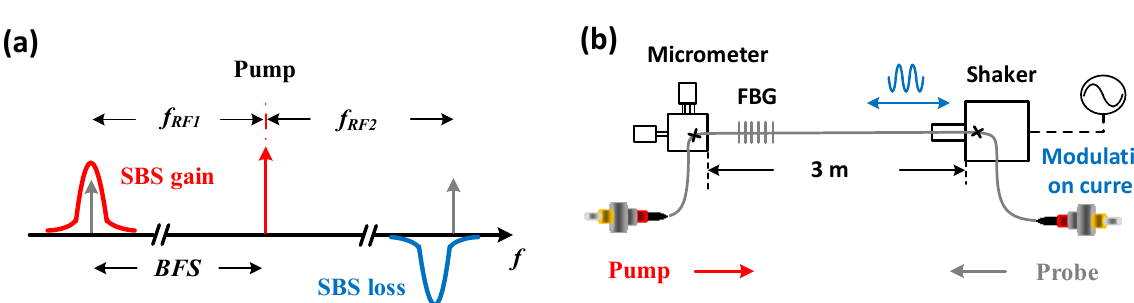
Figure 8. ( a ) Schematic spectrum of the multi-probe wave scheme and ( b ) specific structure of the sensing fiber.